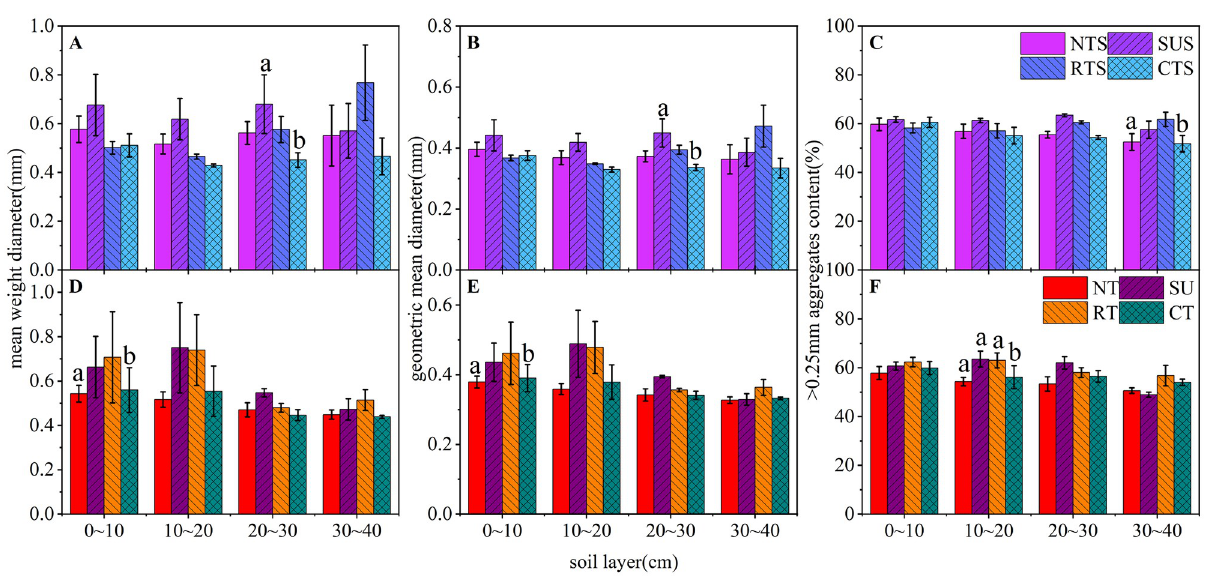
Fig 2. Effects of tillage cultivation on MWD, GMD, and R 0.25 in the 0–40 cm soil layer (2020). Note: The error bars indicate a significant difference at the P < 0.05 level (two–tailed test).